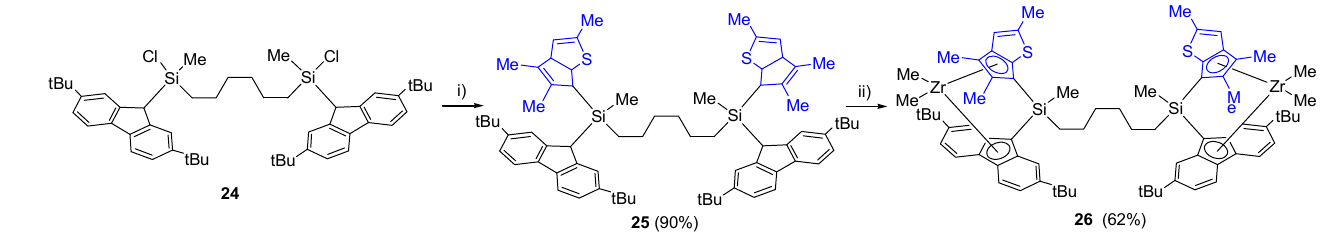
Table 1. Ethylene/1-hexene copolymerization results for the supported catalysts prepared with ansa - zirconocene complexes a,b